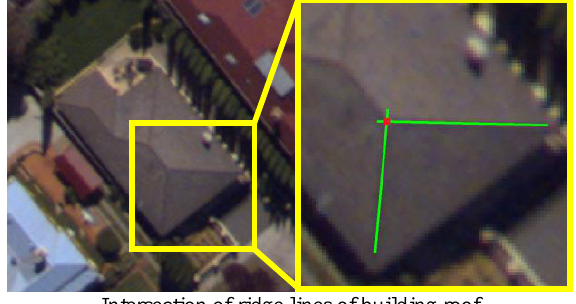
Figure 2. The procedure of point-feature extraction from point cloud and imagery data